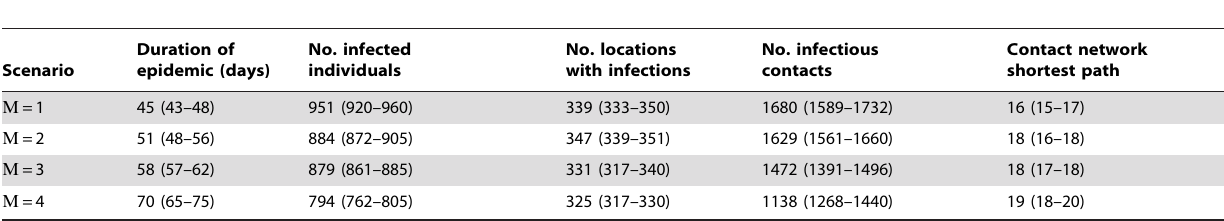
Table 2. Topological metrics of the transmission networks (median, Q1-Q3) obtained after running 50 simulations of the individual based model of the transmission of a directly transmitted pathogen during a 105 day